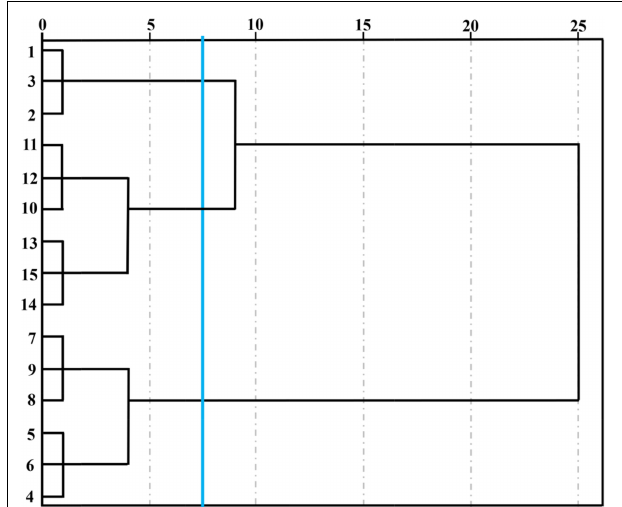
FIGURE 4 | Hierarchical cluster analysis (HCA) of cut lilies during the postharvest process based on E-nose date. Note: cut lilies on day 0 (1, 2, 3), on day 2 (4, 5, 6), on day 4 (7, 8, 9), on day 6 (10, 11, 12) and on day 8 (13, 14,